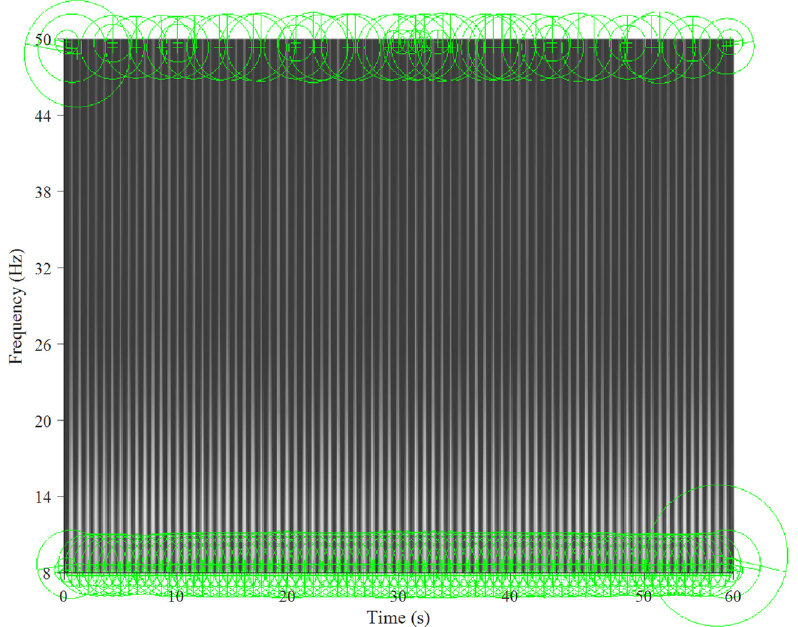
Figure 5. Key points extracted from an ECG spectrogram of normal breathing for a 60 s window and 8–50 Hz band.